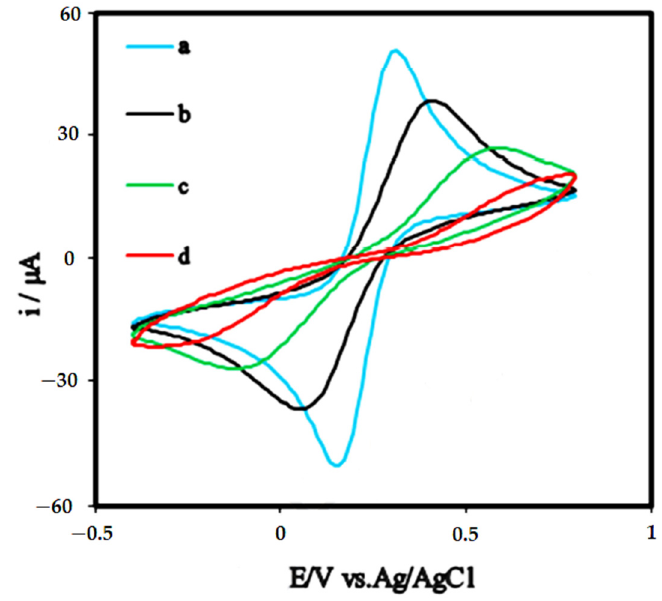
Figure 13. Cyclic voltammogram data recorded for ( a ) GCE, ( b ) RGO/GCE, ( c ) anti-CEA/RGO/GCE, and ( d ) anti-CEA/RGO/GCE biosensor incubated with CEA protein at a scan rate of 25 mV s − 1 in a 0.1 M PBS solution (pH 7.4) containing 5 mM of the ferro-ferricyanide probe. Reprinted with permission from Ref. [189]. Copyright 2021, Elsevier.